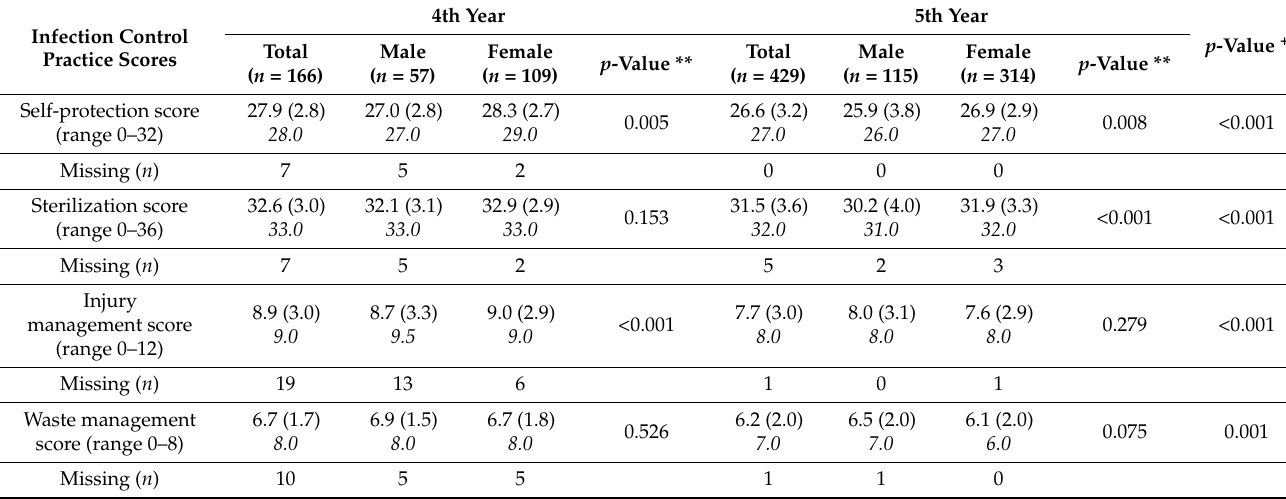
Table 1. Scores of infection control practices among fourth- and fifth-year students in four Egyptian public dental schools. Infection Control Practice